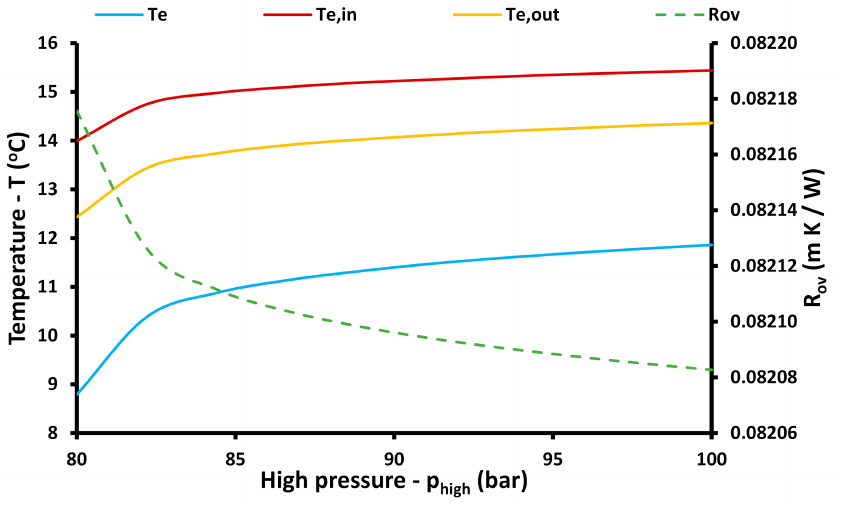
Figure 5. The impact of the high pressure on the evaporator temperature levels and on the overall resistance.